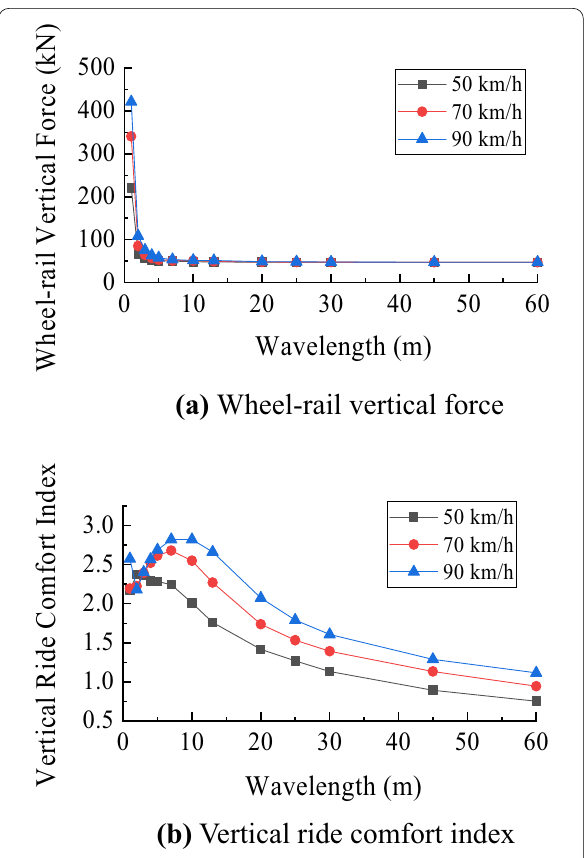
Figure 7 Influence of 10 mm height irregularity wavelength amplitude on wheel-rail vertical force and the vertical ride comfort